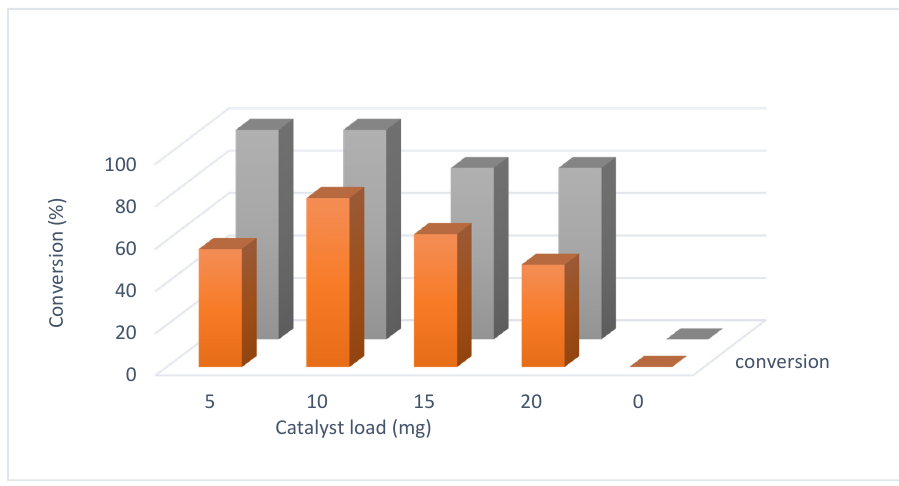
Catalyst load (mg) Figure 8. The effect of the amount of catalyst on the oxidation of VAL using NiFe 2 O 4 . When the TEMPO amount was increased from 5 to 7 mg (Figure 9), the conversion of VAL increased from 49% to 78%, with 99% selectivity of the main product in both cases. When the TEMPO amount was increased to 14 mg, the conversion was improved with 88.5% and 99.9% selectivity to VN. Upon a further increase of the TEMPO amount to 20 mg, the conversion remained the same, but the selectivity of VN decreased to 82% due to the formation of vanillic acid as a byproduct. In the absence of TEMPO the VN formation was noted, but in low yield, indicating that TEMPO has a significant role in the reaction mechanism via stabilizing the radical OH which contributes to the formation of the hyde.